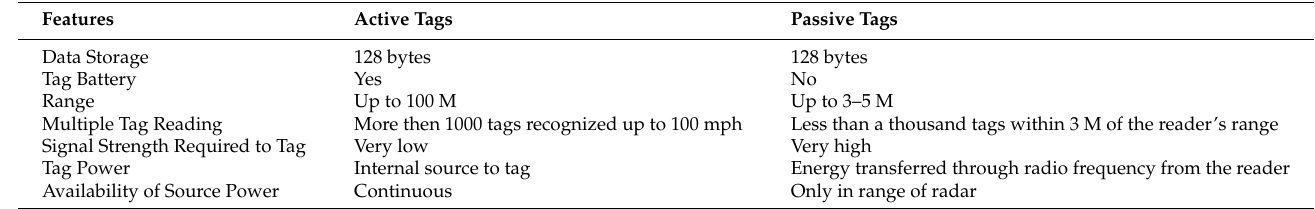
Table 1. IoT-based RFID tag features’